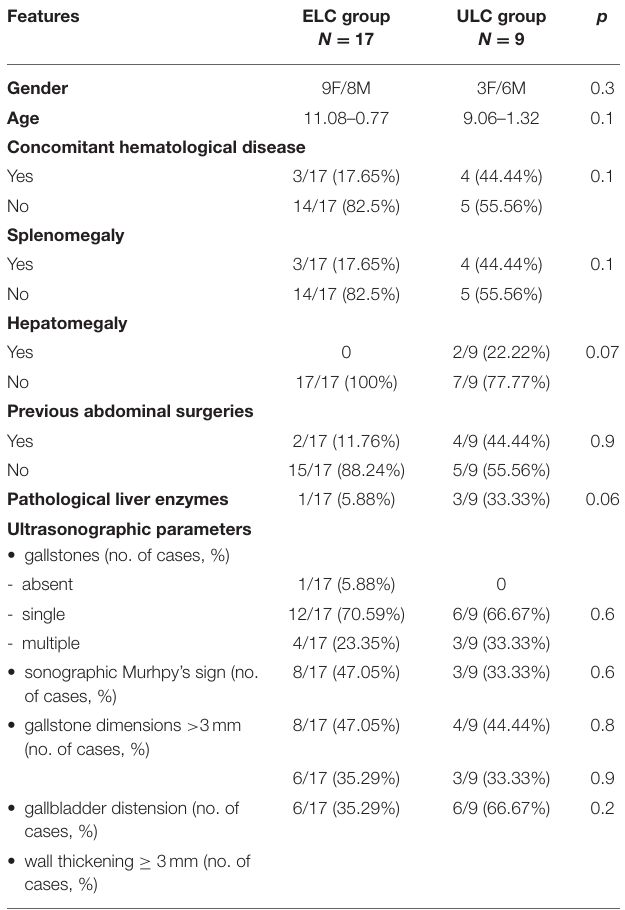
TABLE 4 | Clinical and ultrasonographic features.